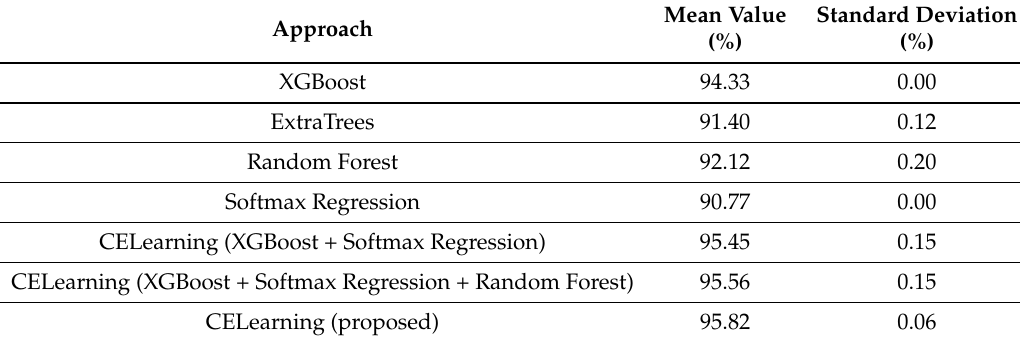
Table 6. Comparison of different combinations of four classifiers based on automatic feature